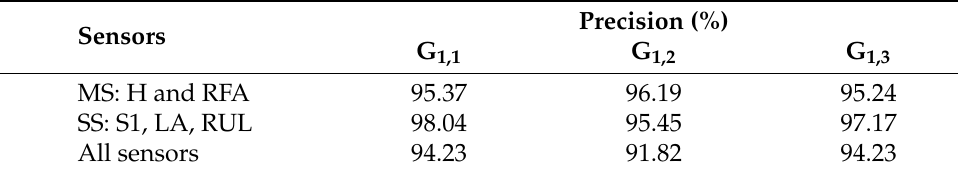
Table 7. Precision achieved for G 1 using HMMs.